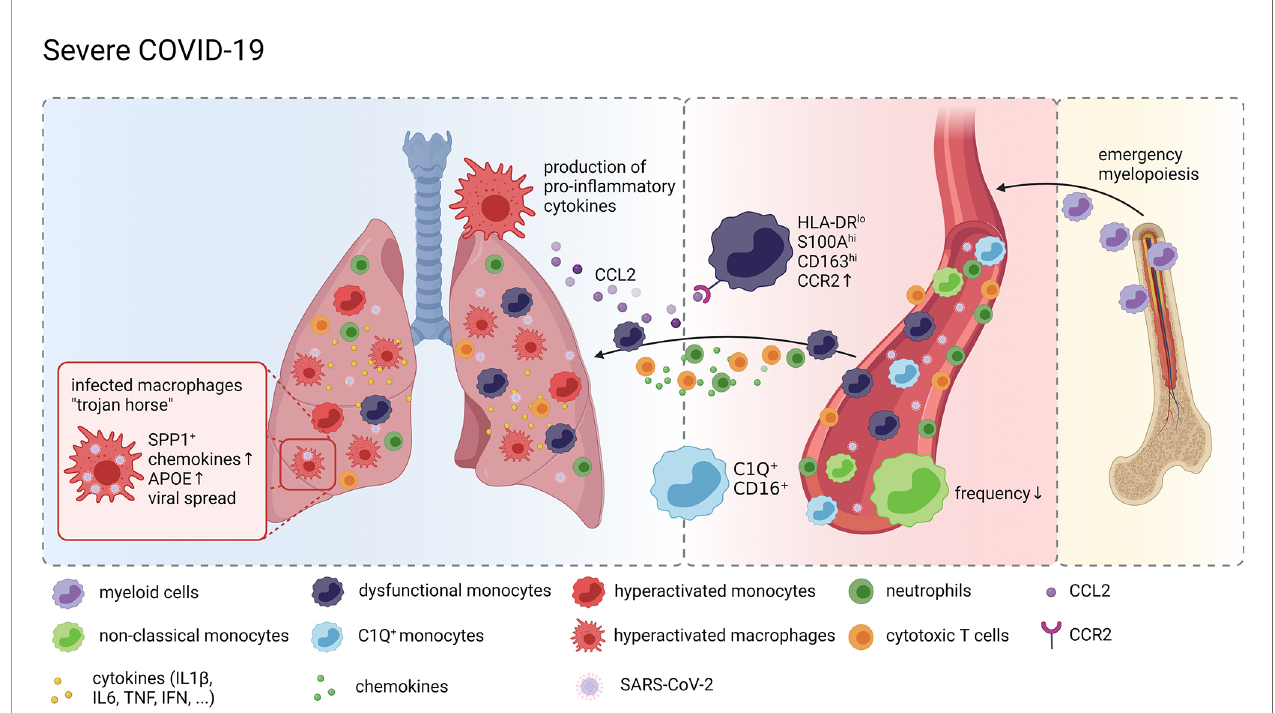
FIGURE 1 | Monocytes and Macrophages in COVID-19. Graphical overview of the compositional and molecular alterations in monocyte and alveolar macrophage populations in COVID-19 created with BioRender.com. Distinct monocyte and macrophage phenotypes were identi fi ed in the peripheral blood of patients with severe COVID-19 including immature cells indicating emergency myelopoiesis, dysfunctional HLA-DR lo classical monocytes and complement gene expressing non-classical monocytes. These cells are attracted to the lung by pro-in fl ammatory chemokines resulting in a continuous accumulation of hyperactivated MNPs producing more pro-in fl ammatory mediators recruiting more in fl ammatory cells, including cytotoxic T cells and neutrophils, thus further exacerbating in fl ammation and tissue damage. SARS-CoV-2 infected macrophages in the lung may act as trojan horses propagating SARS-CoV-2 infection and spreading hyperin fl ammation across the